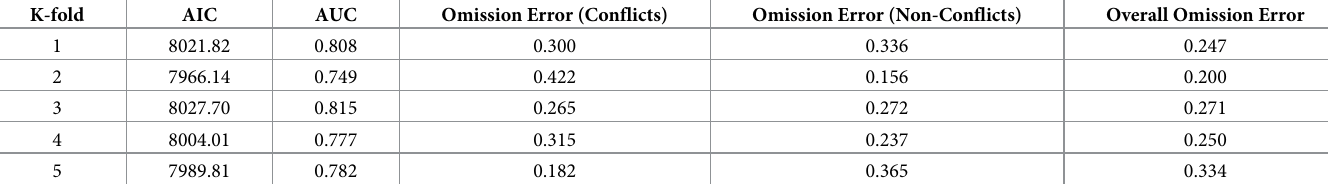
Table 4. Results of k-fold cross